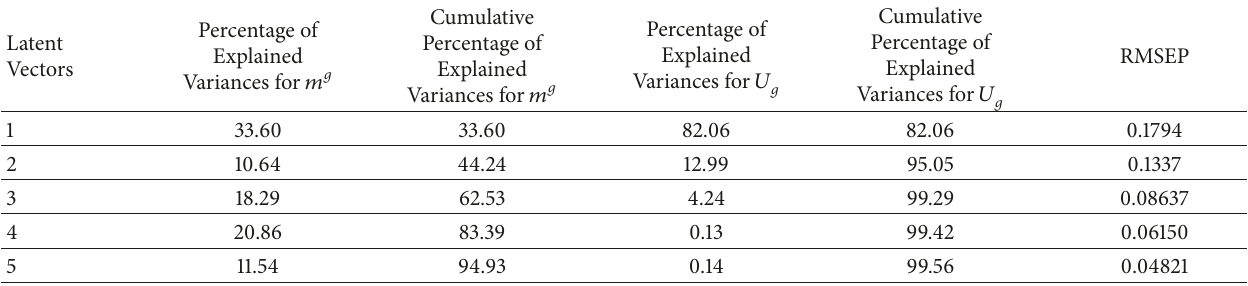
Table 8: Variance of 𝑚 𝑔 and 𝑈 𝑔 explained by the latent vectors and RMSEP for Dominican Republic. Latent Vectors